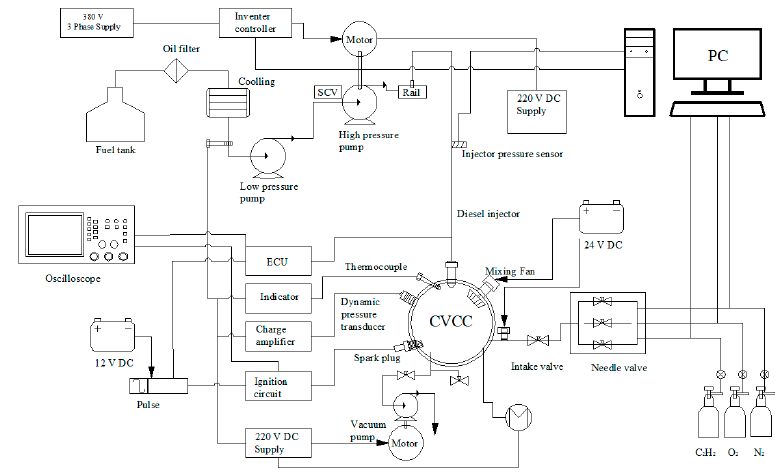
Figure 2. Experimental arrangement diagram of the CVCC system.